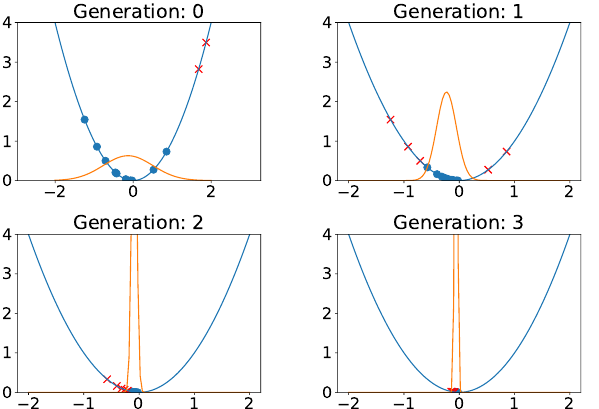
Figure 2. An illustration of a population-based optimization of a quadratic function (blue solid line) using the Estimation of Distribution Algorithm. At each generation a population is selected (blue nodes) and weakest individuals are discarded (red crosses). New candidate solutions are generated by sampling from the normal distribution fit to the previous population (orange solid